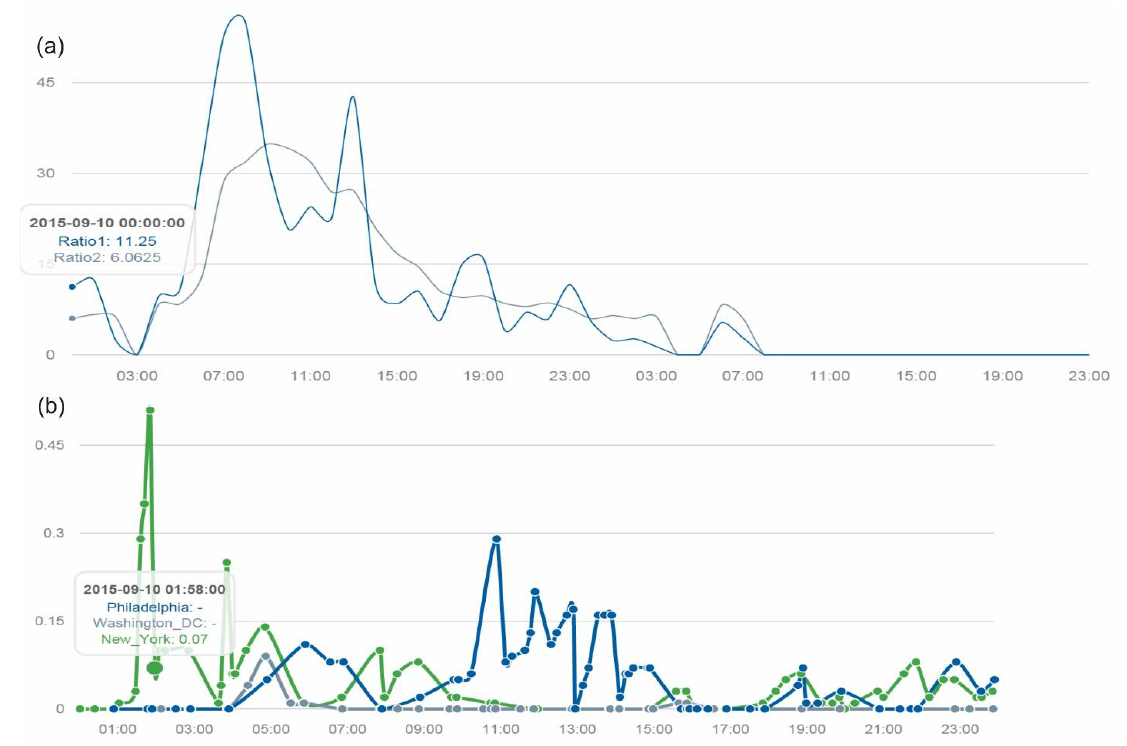
Figure 6. ( a ) Temporal spectrum of rain-related tweets between 0–24 10 September. ( b ) The actual precipitation in inches in three cities on the same day.